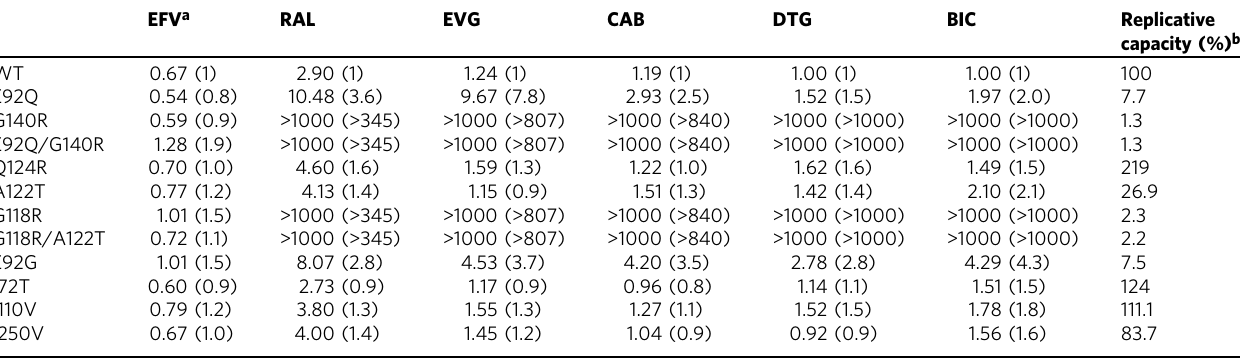
Table 2 Susceptibility to integrase inhibitors and replicative capacity of site-directed mutants containing integrase mutations EFV a RAL EVG